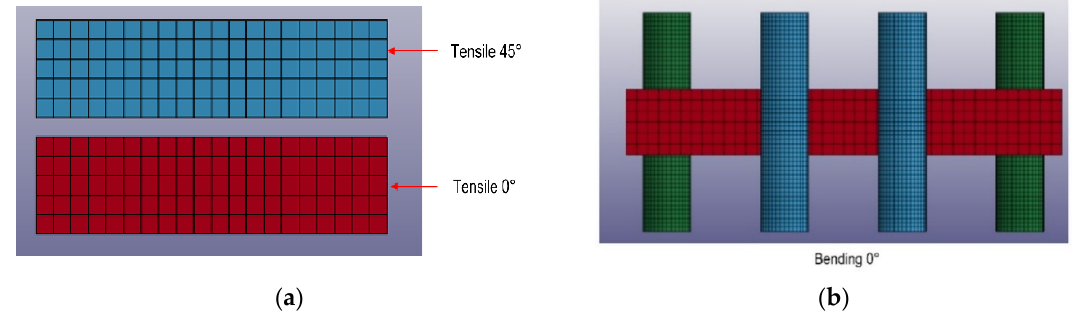
Figure 13. Finite Element Analysis (FEA) models of the specimens for material card setting: ( a ): Tensile specimens, ( b ): Bending specimen.